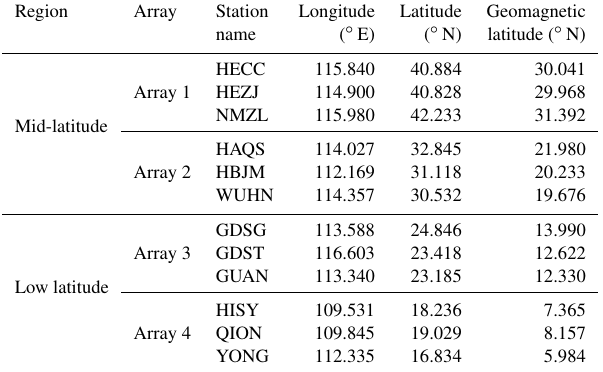
Table 1. Geographic and geomagnetic coordinates of stations from GPS arrays.